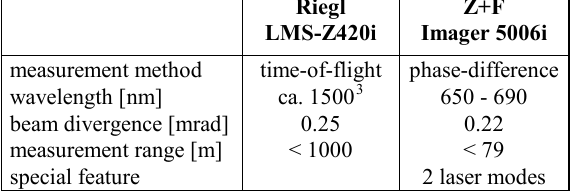
Table 1. Specifications of the used terrestrial laser scanners